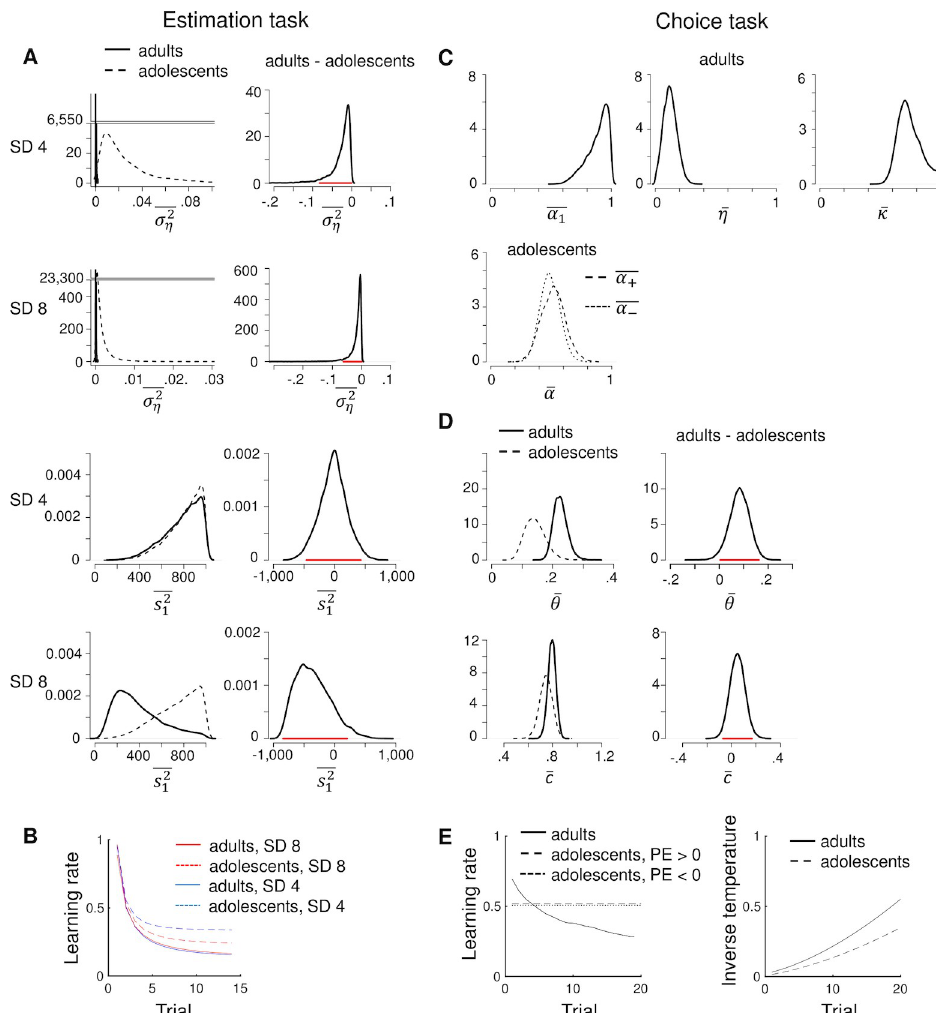
Fig 5. Parameter estimates. A . Posterior distributions for the group-level central tendencies of the Kalman-filter parameters per age group (left panels) and the corresponding difference distributions (right panels; red lines are 95% HDIs) for fits to the estimation data. For visualization purposes, we omitted y-axis values between 40 and 6,550 and between 500 and 23,300, respectively, in the two upper left plots. B . Model’s predicted learning rate per trial for fits to the estimation data. We used the medians of the individual-level posterior distributions to compute trial-specific learning rates per participant, and plotted the average data for each age group. C . Posterior distributions for the group- level means of the reinforcement learning/Pearce-Hall hybrid (adults) and asymmetric reinforcement learning (adolescents) parameters for fits to the choice data. The SD of the outcome-generating distribution in the choice task was always 8. D . Posterior distributions for the group-level means of the dynamic-softmax parameters per age group (left panels) and the corresponding difference distributions (right panels) for fits to the choice data. E . Model’s predicted learning rate and inverse temperature per trial for fits to the choice data, computed as in Fig B. PE = prediction error. Note that the adolescents’ learning rates following positive and negative prediction errors almost